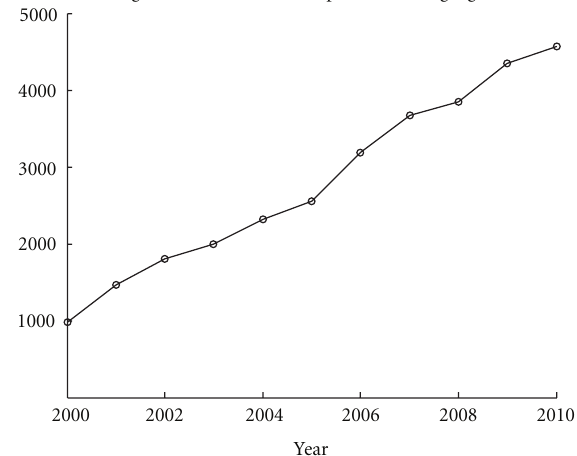
Figure 3: Linear growth of yearly Google Scholar hits for “com- pressed sensing algorithm” over the last decade. The steadily grow- ing number indicates the increasing di ffi culty of keeping pace with algorithmic improvements in compressed